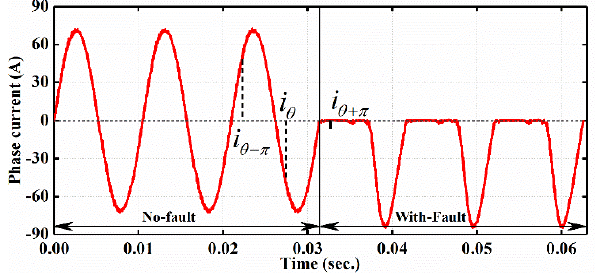
Figure 2. Performance of phase current with occurrence of T1 fault at 360 rpm/30 Nm condition.